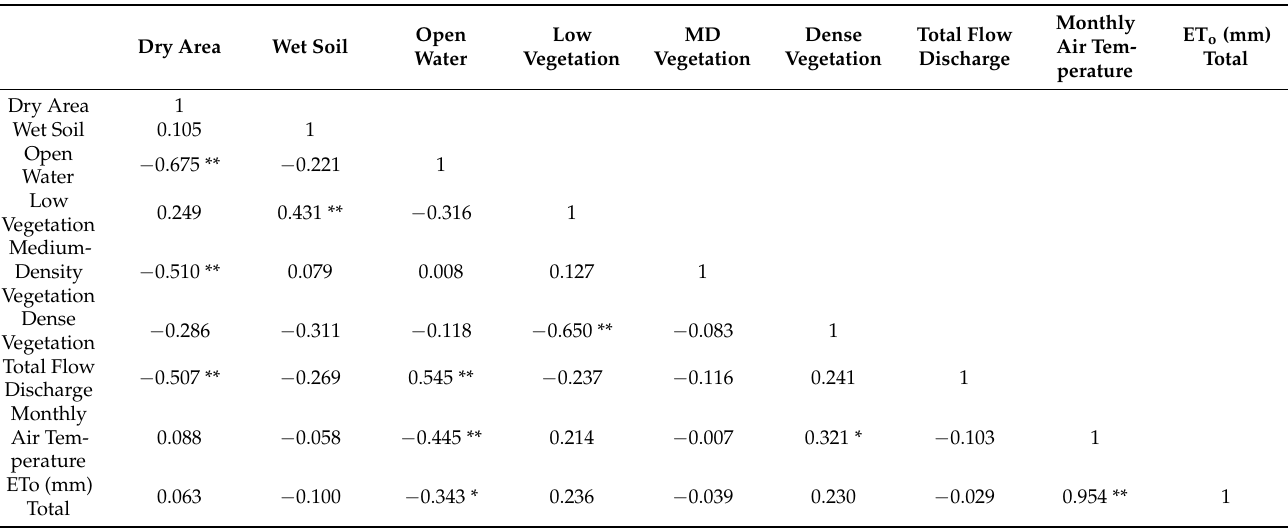
Table 3. Results of correlation (R) between dependent and independent variables for a statistical model.